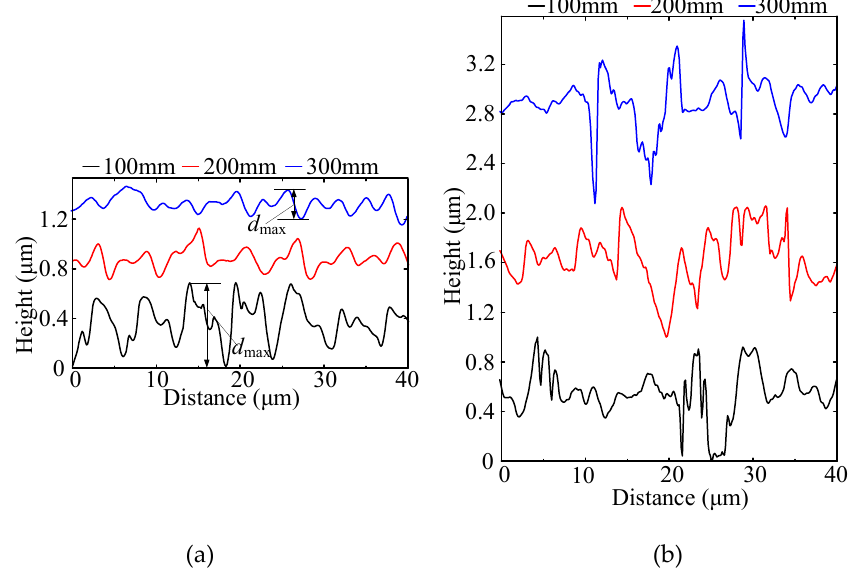
Figure 6. Profiles of milled BMG and aluminum workpiece. ( a ) The BMG material; ( b ) the aluminum